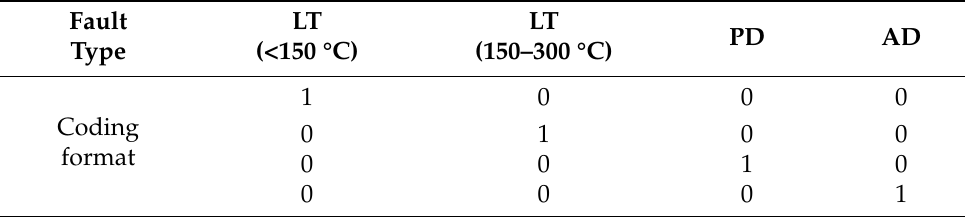
Table 2. Coding format for different fault types.